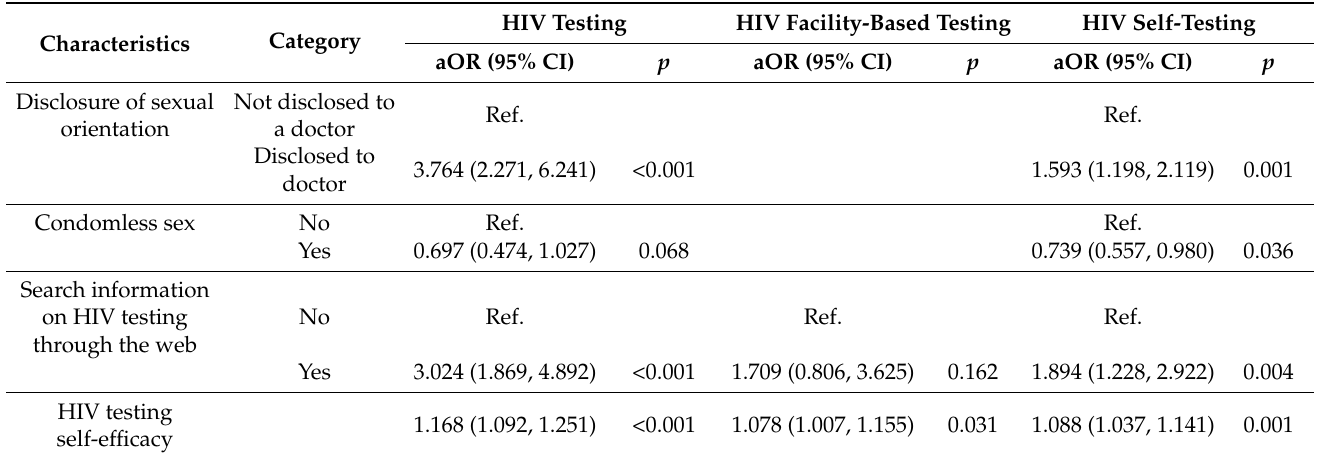
Table 4. Factors related to HIV testing in their lifetime among MSM.